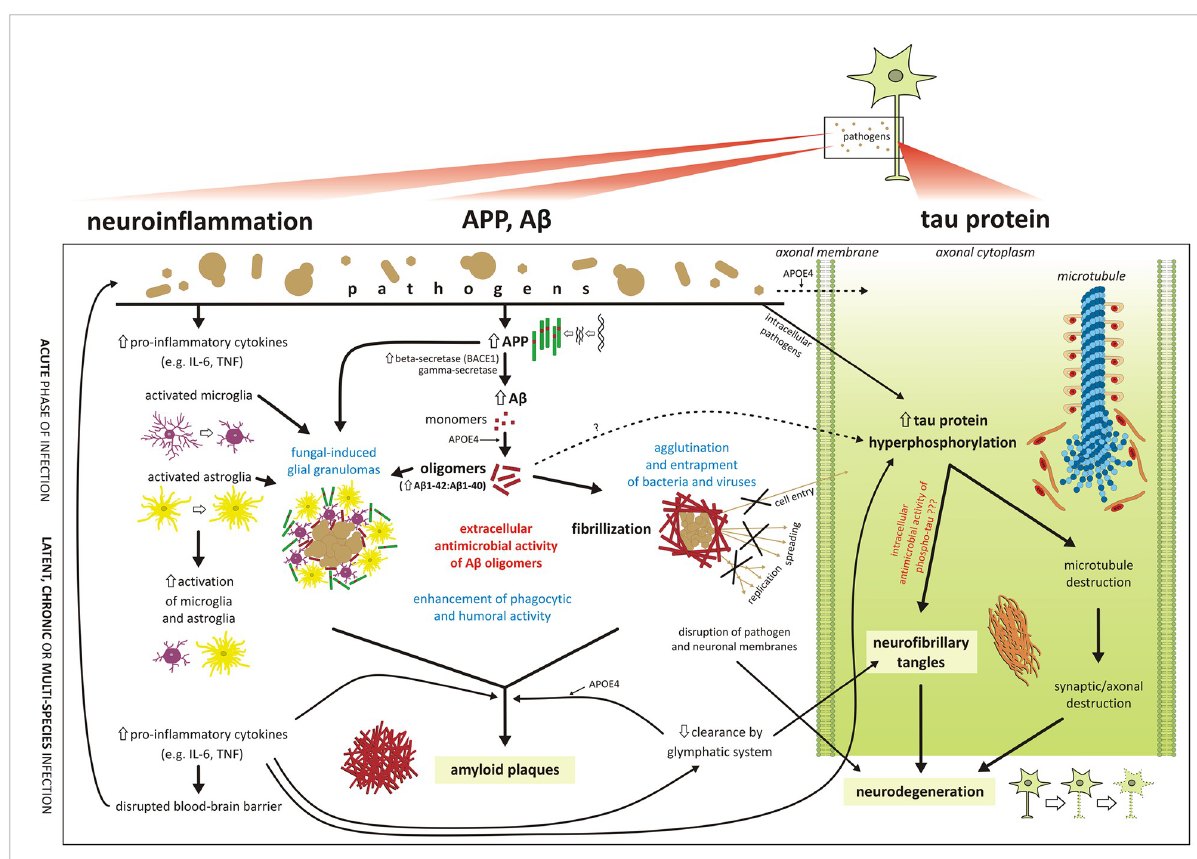
Fig 4. Schematic illustrating the infectious hypothesis of AD. The scheme follows the 3 main domains of AD: neuroinflammation, amyloid pathology, and tau protein pathology, progressing from the top to the bottom. Pathogens (bacteria, viruses, and/or fungi) entering the CNS activate the innate immunity. If the inflammatory process becomes chronic, the BBB is disrupted, facilitating entrance of further pathogens into the brain. Expression of APP and its cleavage to A β is enhanced in reaction to pathogens. A β monomers cluster into oligomers that can entrap various pathogens (agglutination or granuloma formation), which prevents them from entering into neurons, spreading or replicating, and facilitates their destruction by microglia. A β fibrils can directly disrupt pathogens’ membranes; however, they may attack neuronal membranes as well. During chronic or latent infections, A β fragments and fibrils accumulate, and finally create insoluble amyloid plaques. Tau pathology is stimulated by A β and neuroinflammation by several pathways and might be directly triggered by intracellular pathogens. An interesting question is whether tau protein could also serve as an intracellular antimicrobial peptide, similarly to A β oligomers. Accumulation of A β and tau is aggravated by impaired clearance activity of the brain glymphatic system, which is also compromised by neuroinflammatory processes. APOE4, the strongest known genetic risk factor of sporadic AD, apparently affects oligomerization or clearance of A β and facilitates entry of some pathogens (e.g., HSV1) into the cell. A β , amyloid beta; AD, Alzheimer’s disease; APOE4, apolipoprotein E4 allele; APP, amyloid precursor protein; BBB, blood–brain barrier; CNS, central nervous system; HSV1, Herpes simplex virus type 1; IL-6, interleukin-6; TNF, tumor necrosis